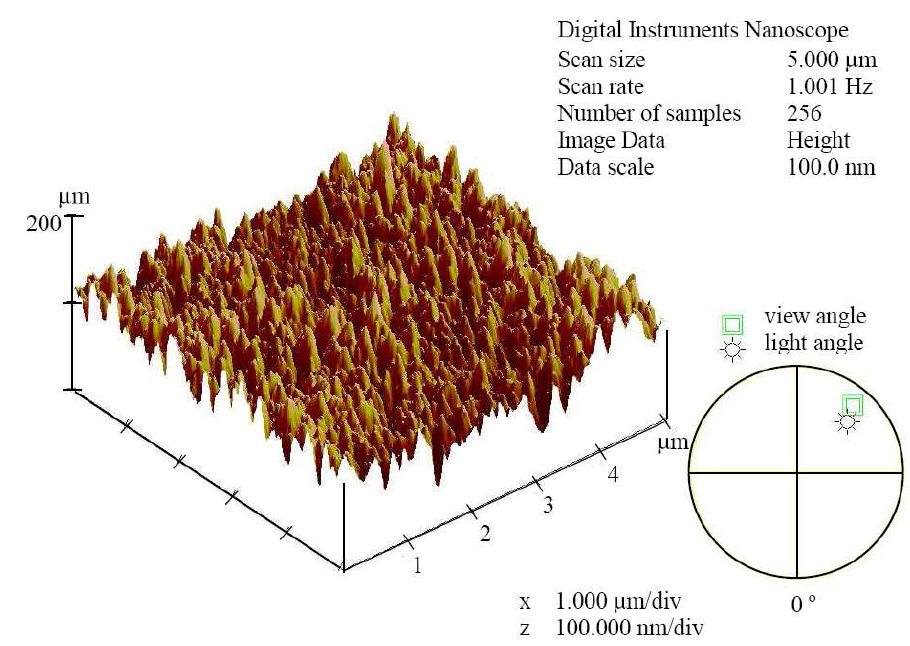
methanol/acetic acid.